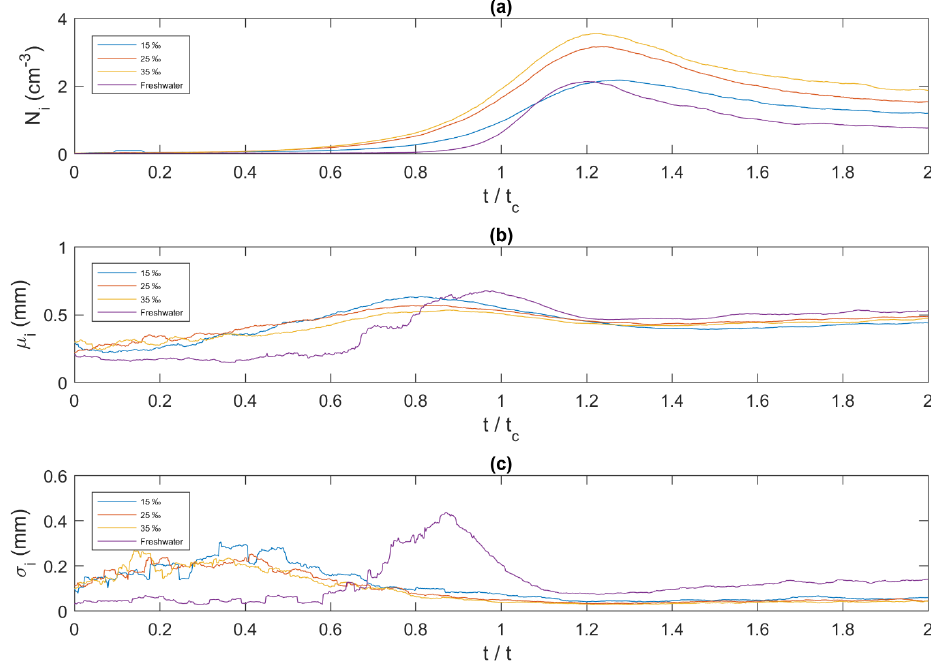
Figure 11. Ensemble-averaged time series of frazil ice particle properties for all four salinities plotted as a function of dimensionless time. (a) N i , the average frazil ice particle concentration (cm − 3 ); (b) µ i , the mean size of frazil ice particles (mm); and (c) σ i , the standard deviation of the size of frazil ice particles (mm). t/t c = 1 corresponds to the time of the minimum temperature on the supercooling curves.